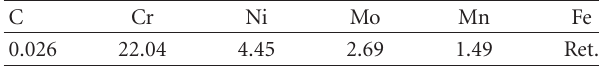
Table 1: Chemical composition of 2205 DSS